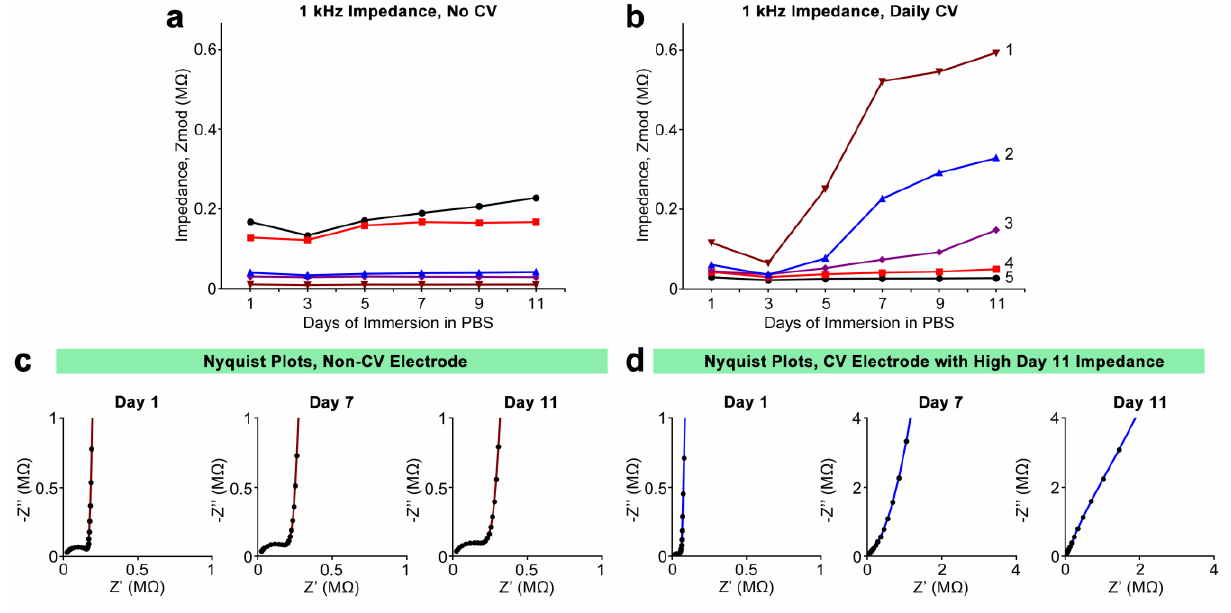
Figure 6. ( a , b ) 1 kHz impedances of individual PEDOT/MWCNT/Dex-coated electrodes chronically submerged in sterile PBS over 11 days. Electrodes in ( a ) were not subjected to daily CV, while those in ( b ) were subjected to daily CV. Electrodes in ( b ) are numerically labeled for reference; ( c , d ) Representative Nyquist plots collected at days 1, 7, and 11 for